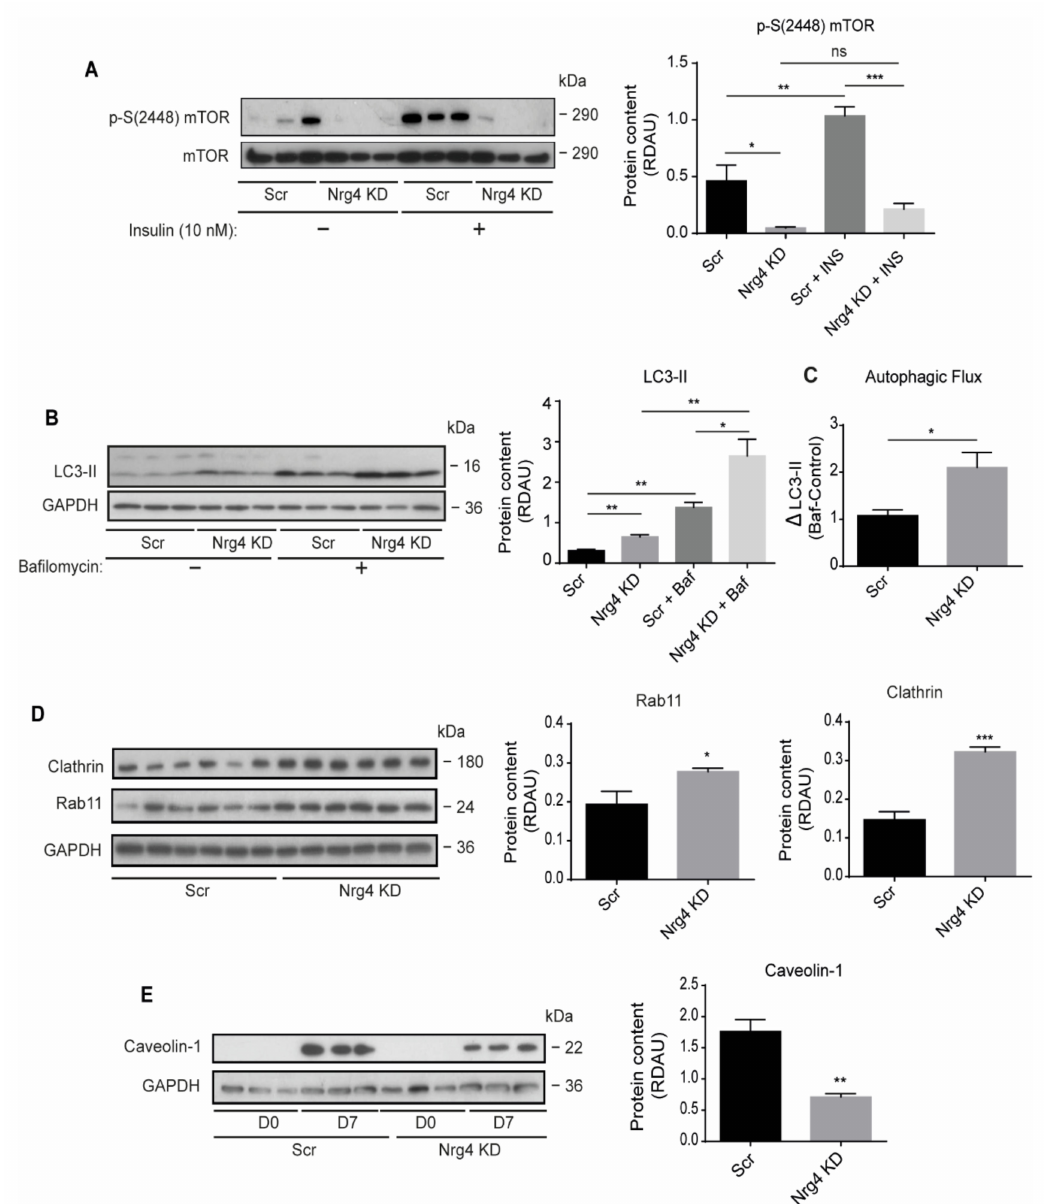
Figure 6. Nrg4 knockdown adipocytes show accelerated autophagy flux and deficient mTORc1 regulation upon insulin treatment: ( A ) Cells were starved without fetal bovine serum for 16 h and then incubated with 10 nM insulin for 30 min. Western blot bands and quantification of phospho (p)-S(2448) mTOR in non-treated and insulin-treated Scr and Nrg4 KD adipocytes at day 7 (D7) of differentiation ( n = 3). P-S(2448) mTOR protein content was normalized to total mTOR protein content. ( B ) Adipocytes were treated with 200 nM bafilomycin A1 for 2 h. Western blot bands and quantification of LC3-II in non-treated or bafilomycin A1-treated Scr and Nrg4 KD adipocytes at D7 ( n = 3). ( C ) Autophagy flux determination in Scr and Nrg4 KD adipocytes. ∆ LC3-II values were calculated by subtracting the mean of LC3-II RDAU values from the non-treated cells to the bafilomycin-treated LC3-II RDAU values ( n = 3). ( D ) Western blot bands and quantification of Clathrin and Rab11 in Scr and Nrg4 KD adipocytes at D7 ( n = 6). Western blots from panel 6D and 2H were performed simultaneously with a single control experiment. ( E ) Representative western blot of Caveolin-1 in Scr and Nrg4 KD adipocytes at D0 and D7 of differentiation, and quantification at D7 ( n = 3). Western blots from panels 6E and 2C were performed simultaneously with a common loading control, GAPDH. Each lane of the blots represents an independent experiment. Overall contrast and brightness of the western blots were adjusted to clarify the images. Data represent mean ± SEM. * p ≤ 0.05, ** p ≤ 0.01, *** p ≤ 0.001, ns (not significant). For the statistical analysis of the graph in panel B, t -tests was used to analyze the statistical differences between